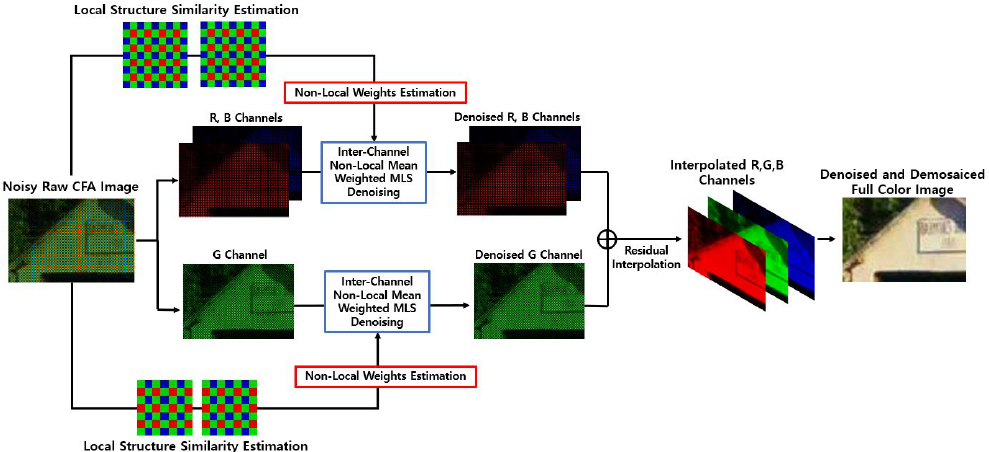
Figure 4. Flow Process of the proposed